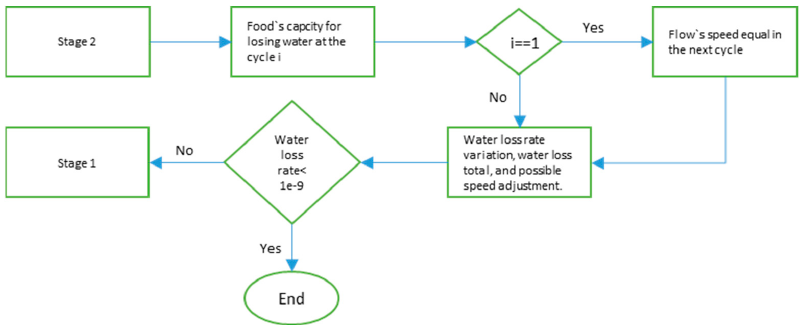
Figure 4. Stage 3 of algorithm. Food humidity calculus and verification as demonstrated from Equation (25) to (33). Inventions 2019 , 4 , x